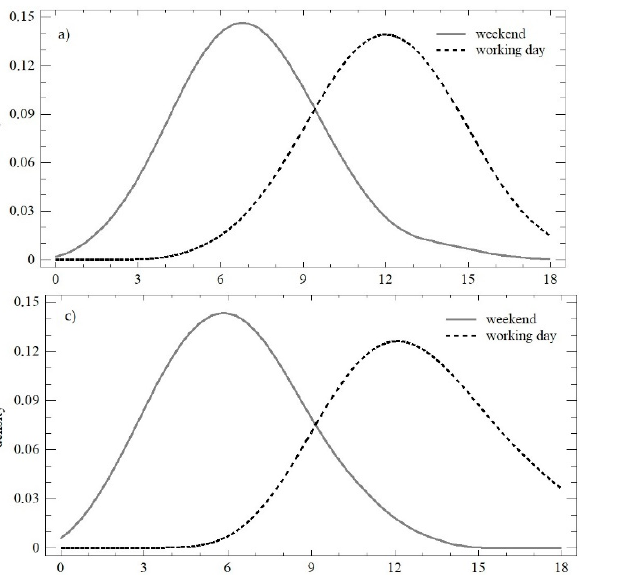
Figure 4. Scatterplot of the numbers of comments across the observation periods: ( a ) working days; ( b ) weekend.